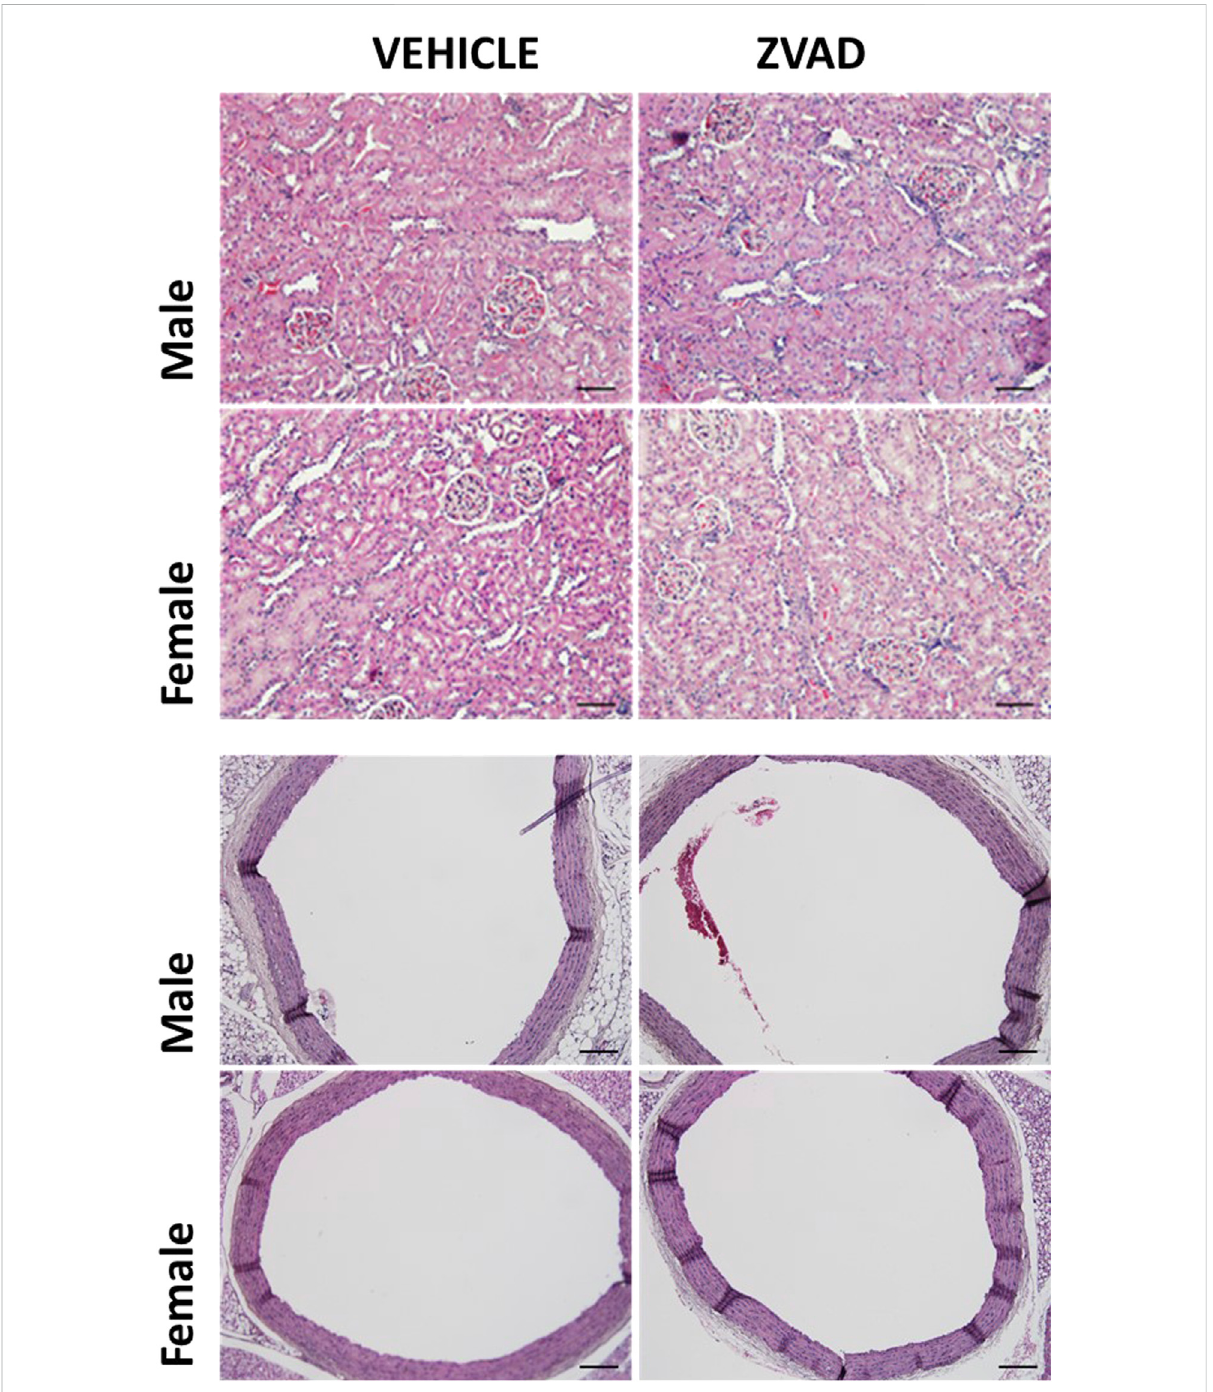
FIGURE 10 TreatmentwithZVAD-FMK for6 weeksdidnotchangeeitheraorticorrenalstructure.Aortaandkidneywereharvestedandformalin fi xedfrom male and female spontaneously hypertensive rats (SHR) treated with vehicle (veh) or ZVAD-FMK (ZVAD) from 6 to 12 weeks of age ( n =